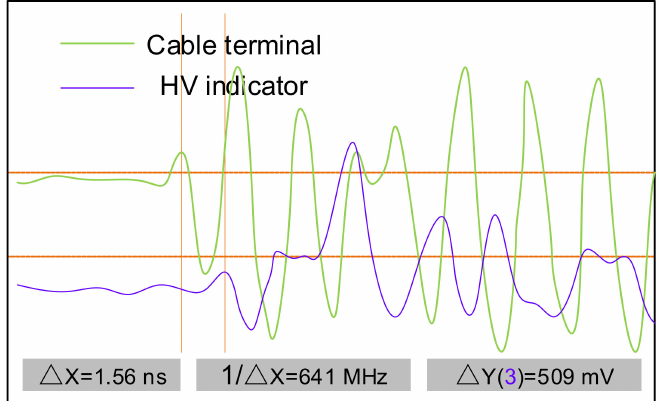
Figure 6. Signal diagram of two detection positions in A-phase cable compartment.